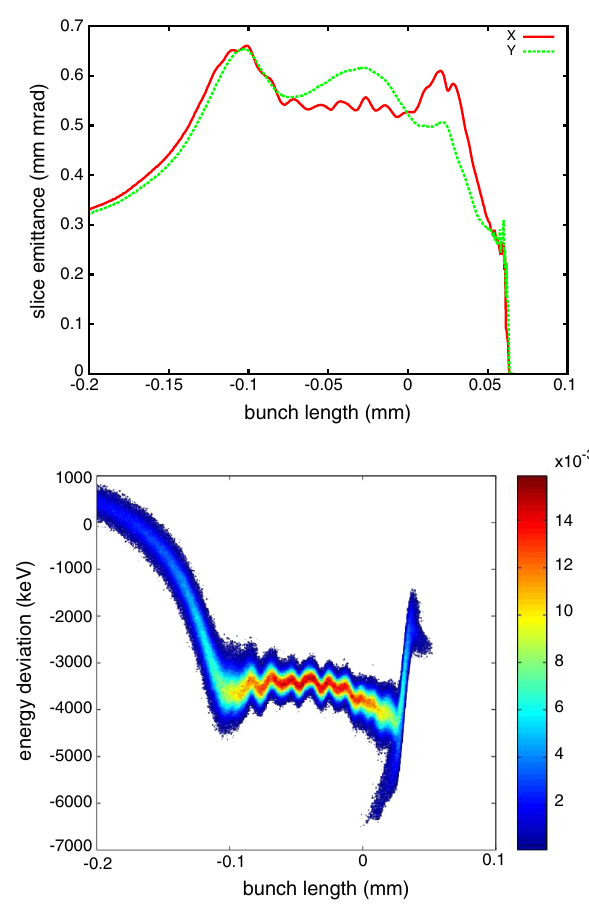
FIG. 11. The slice emittances (top) and longitudinal phase space distribution (bottom) at the entrance of the undulator from simulation using the real number of